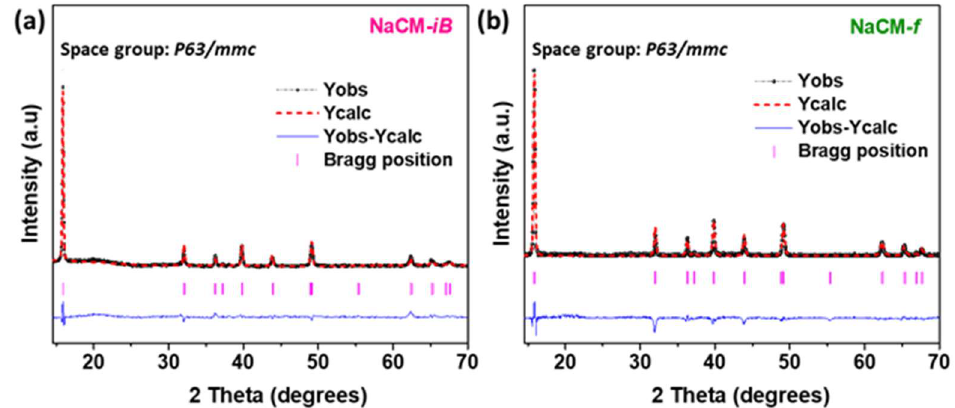
Figure 3. Rietveld-refined patterns of the ( a ) NaCM -iB and ( b ) NaCM -f samples.